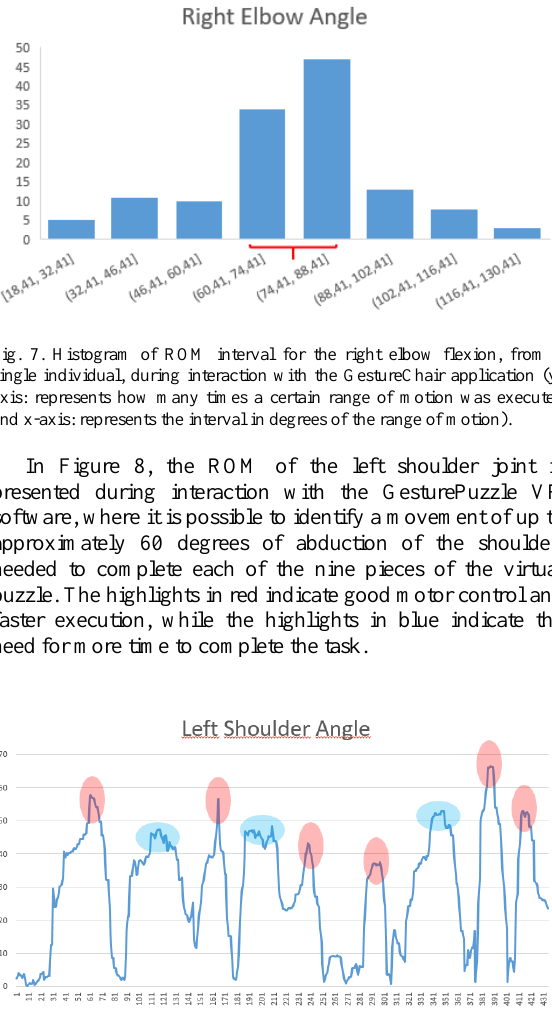
Fig. 8. ROM of the left shoulder, from the single individual, during the GesturePuzzle execution (y-axis: represents degrees of range of motion and x-axis: represents the number of samples collected in